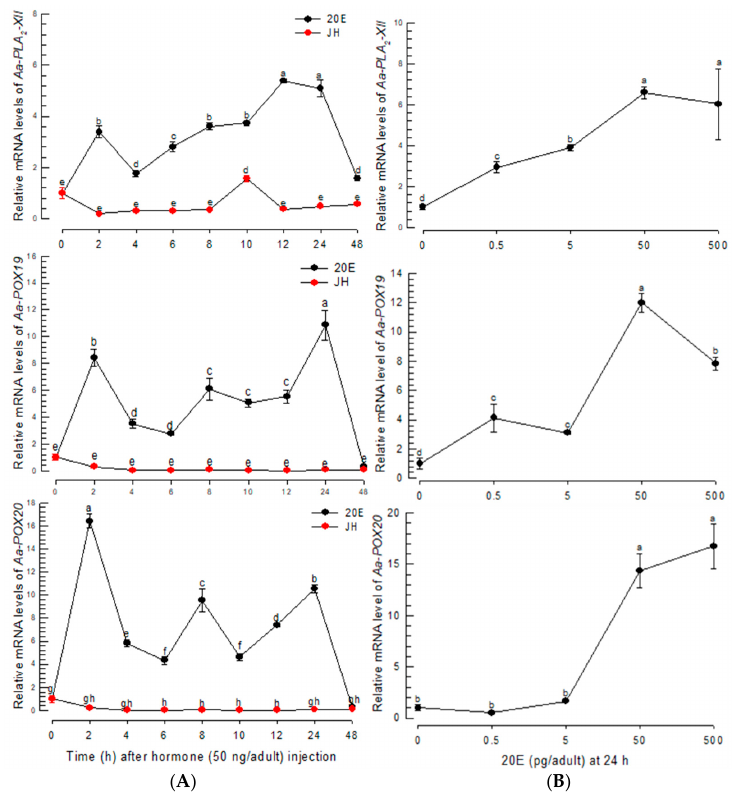
Figure 5. Inducible expressions of PG biosynthesis-associated genes in response to 20E in Ae. al- bopictus . ( A ) Expression profiles of Aa-PLA 2 -XII , Aa-POX19 , and Aa-POX20 in response to 20E (50 ng/adult) and JH (50 ng/adult). ( B ) Dose-response of 20E against the gene expressions. Dimethyl- sulfoxide (‘DMSO’, 10%) used to dissolve hormones was injected as a control (‘CON’). Three insects were used for each treatment. Each treatment was replicated three times with independent tissue preparations. The different letters above the standard error bars indicate significant differences among means at Type I error = 0.05 (LSD